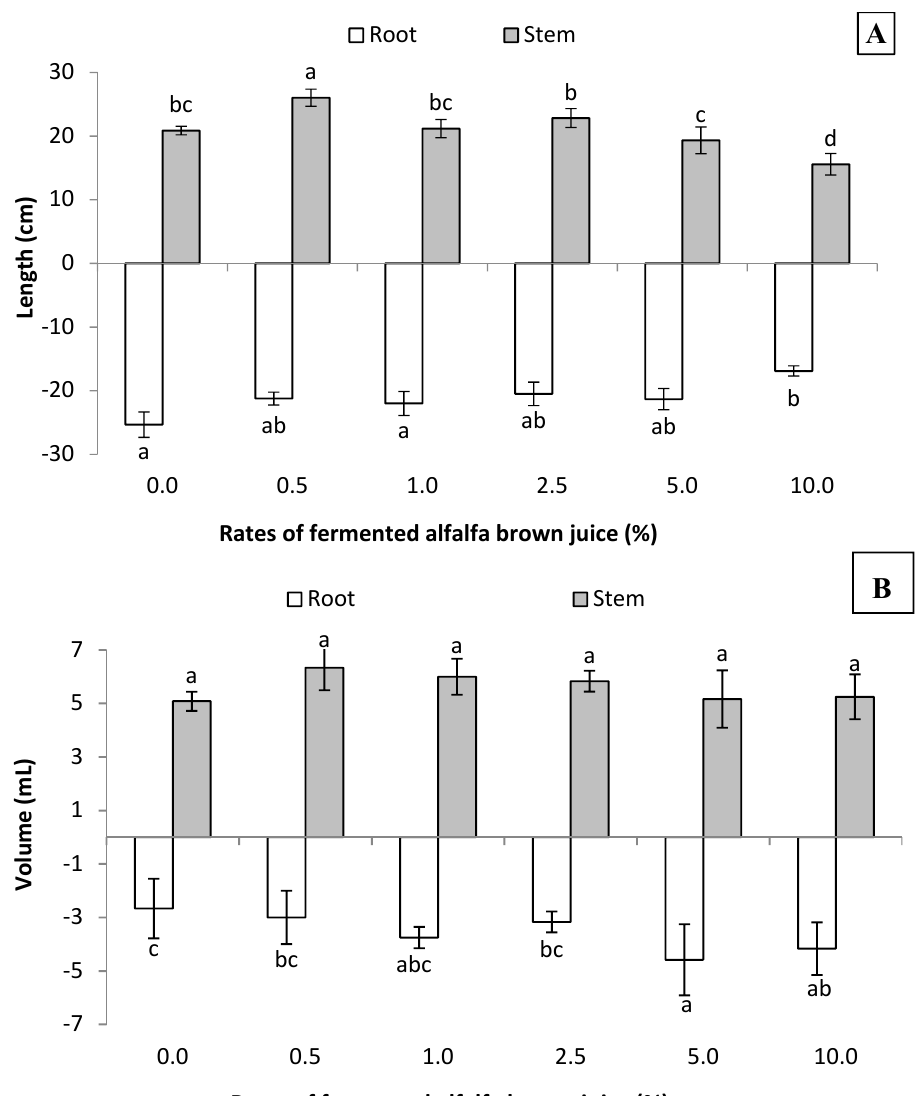
Figure 1. Length ( A ) and volume ( B ) of root and stem systems of Celosia plants fertilized at different rates of fermented alfalfa brown juice applied as a foliar application. Sample size ( n = 6). Different letters above the same columns show significant differences at the level of p < 0.05.